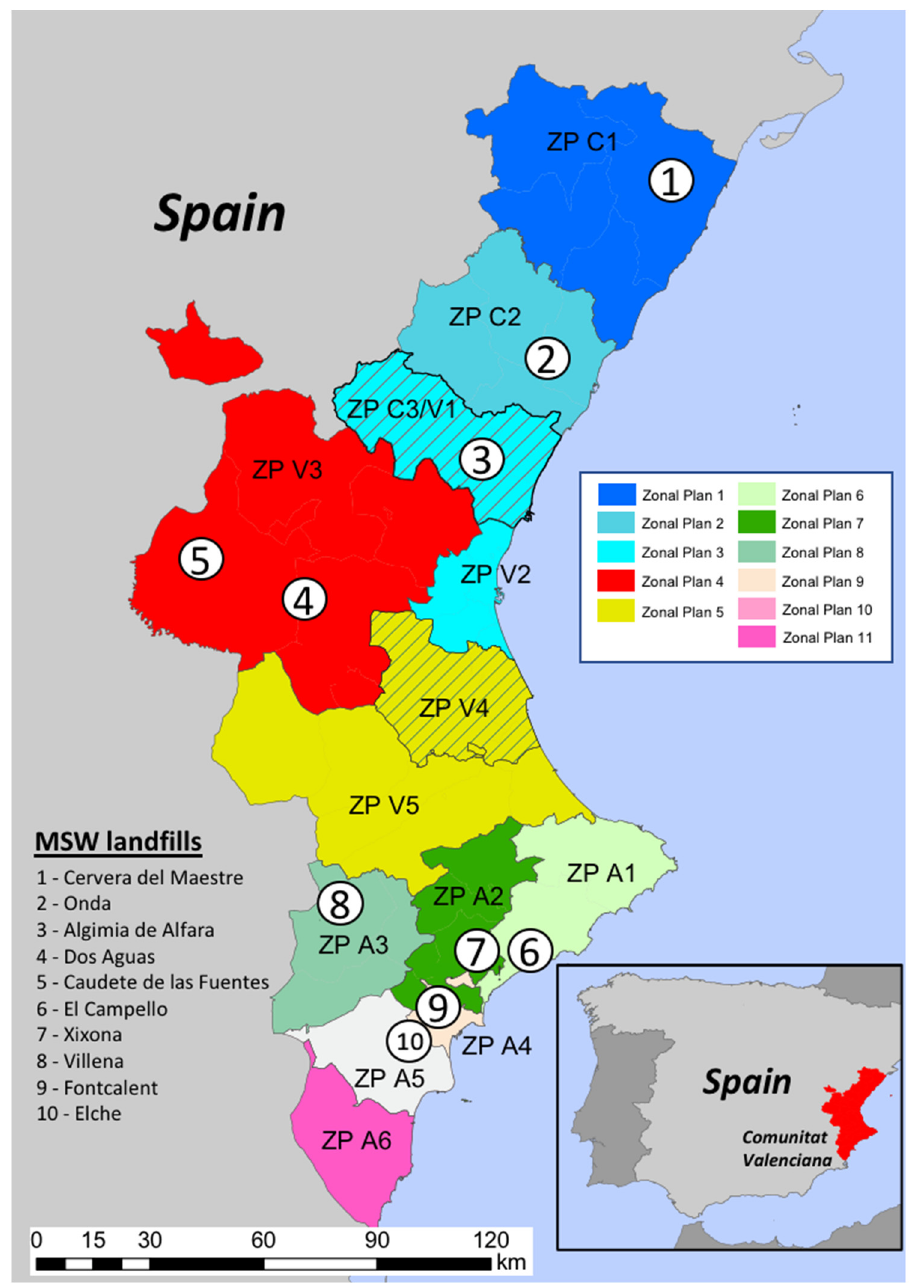
Figure 2. Location of the 10 sanitary landfills currently in operation inside Valencia Community and delimitation of the MSW Zonal Plans.